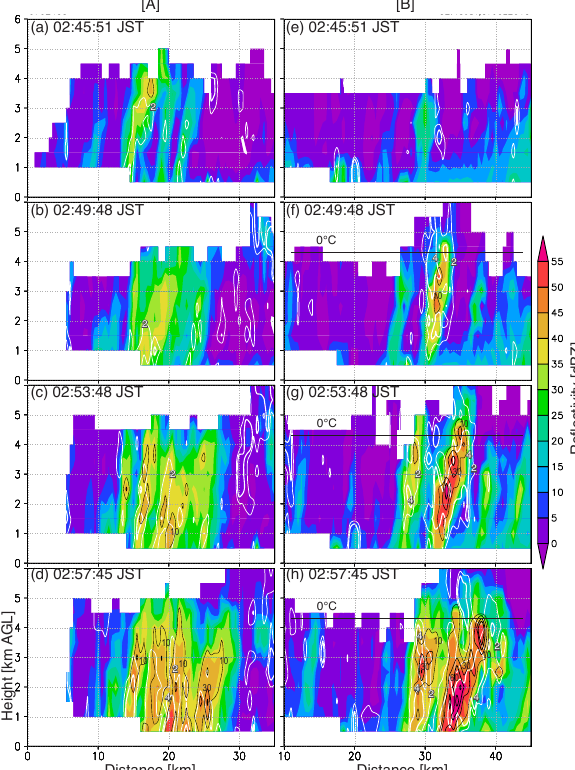
Figure 9. Distance-height cross-section of rainfall rate and differential reflectivity ( Z DR ) superimposed over Fig. 9. Distance-height cross section of rainfall rate and differen- (cid:87)(cid:75)(cid:72)(cid:3)(cid:68)(cid:87)(cid:87)(cid:72)(cid:81)(cid:88)(cid:68)(cid:87)(cid:76)(cid:82)(cid:81)(cid:16)(cid:70)(cid:82)(cid:85)(cid:85)(cid:72)(cid:70)(cid:87)(cid:72)(cid:71)(cid:16)(cid:85)(cid:68)(cid:76)(cid:81)(cid:16)(cid:82)(cid:81)(cid:79)(cid:92)(cid:3)(cid:85)(cid:72)(cid:193)(cid:72)(cid:70)(cid:87)(cid:76)(cid:89)(cid:76)(cid:87)(cid:92)(cid:3)(cid:82)(cid:73)(cid:3)(cid:36)(cid:3)(cid:11)(cid:68)(cid:16)(cid:71)(cid:12)(cid:3)(cid:68)(cid:81)(cid:71)(cid:3)(cid:37)(cid:3)(cid:11)(cid:72)(cid:16)(cid:75)(cid:12)(cid:3)(cid:68)(cid:79)(cid:82)(cid:81)(cid:74)(cid:3)(cid:87)(cid:75)(cid:72)(cid:3)(cid:68)(cid:81)(cid:68)(cid:79)(cid:92)(cid:87)(cid:76)(cid:70)(cid:3)(cid:68)(cid:85)(cid:72)(cid:68)(cid:3)(cid:76)(cid:81)(cid:3)(cid:41)(cid:76)(cid:74)(cid:17)(cid:3)(cid:27)(cid:17)(cid:3)(cid:37)(cid:79)(cid:68)(cid:70)(cid:78)(cid:3) tial reflectivity ( Z DR ) superimposed over the attenuation-corrected- contours indicate estimated rainfall rates of 10, 30, 60 and 90 mm h -1 , and white contours depict differential (cid:85)(cid:72)(cid:193)(cid:72)(cid:70)(cid:87)(cid:76)(cid:89)(cid:76)(cid:87)(cid:92)(cid:3)(cid:68)(cid:87)(cid:3)(cid:21)(cid:3)(cid:68)(cid:81)(cid:71)(cid:3)(cid:23)(cid:3)(cid:71)(cid:37)(cid:15)(cid:3)(cid:85)(cid:72)(cid:86)(cid:83)(cid:72)(cid:70)(cid:87)(cid:76)(cid:89)(cid:72)(cid:79)(cid:92)(cid:17)(cid:3)(cid:55)(cid:75)(cid:72)(cid:3)(cid:82)(cid:69)(cid:86)(cid:72)(cid:85)(cid:89)(cid:68)(cid:87)(cid:76)(cid:82)(cid:81)(cid:3)(cid:87)(cid:76)(cid:80)(cid:72)(cid:3)(cid:76)(cid:86)(cid:3)(cid:86)(cid:75)(cid:82)(cid:90)(cid:81)(cid:3)(cid:76)(cid:81)(cid:3)(cid:87)(cid:75)(cid:72)(cid:3)(cid:88)(cid:83)(cid:83)(cid:72)(cid:85)(cid:16)(cid:79)(cid:72)(cid:73)(cid:87)(cid:3)(cid:82)(cid:73)(cid:3)(cid:72)(cid:68)(cid:70)(cid:75)(cid:3)(cid:76)(cid:80)(cid:68)(cid:74)(cid:72)(cid:17) rain-only reflectivity of A (a–d) and B (e–h) along the analytic area in Fig. 8. Black contours indicate estimated rainfall rates of 10, 30, 60 and 90mmh − 1 , and white contours depict differential reflectiv- ity at 2 and 4dB, respectively. The observation time is shown in the upper-left of each